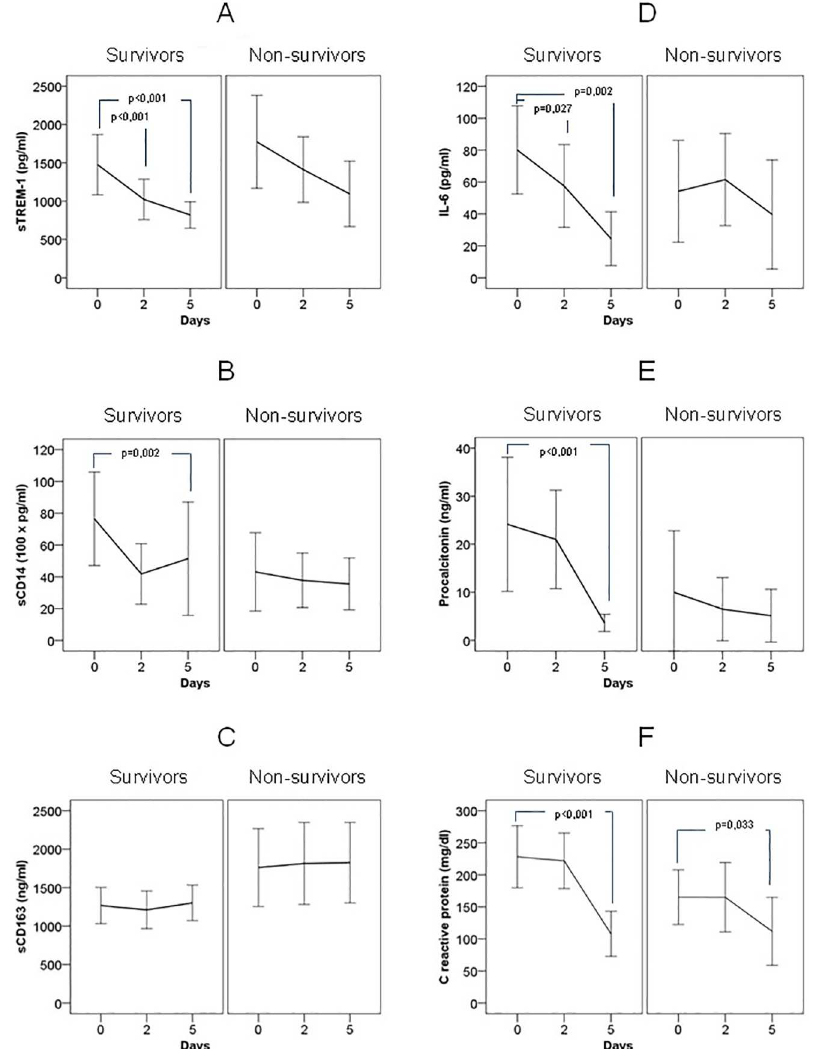
Fig 2. Changesof serum concentrations of sTREM-1 (A), sCD14 (B), sCD163(C), IL-6 (D), procalcitonin (E) and C reactive protein (F) of patients with severe sepsis/septic shock duringthe first 5 days of ICU stay. Patients are classifiedin two groups: survivors and non-survivors. Data are shown as mean (95% confidence interval). Significant differences in sTREM-1, IL-6, procalcitoninand C reactive protein from day 0 to day 5 of ICU stay were detected in